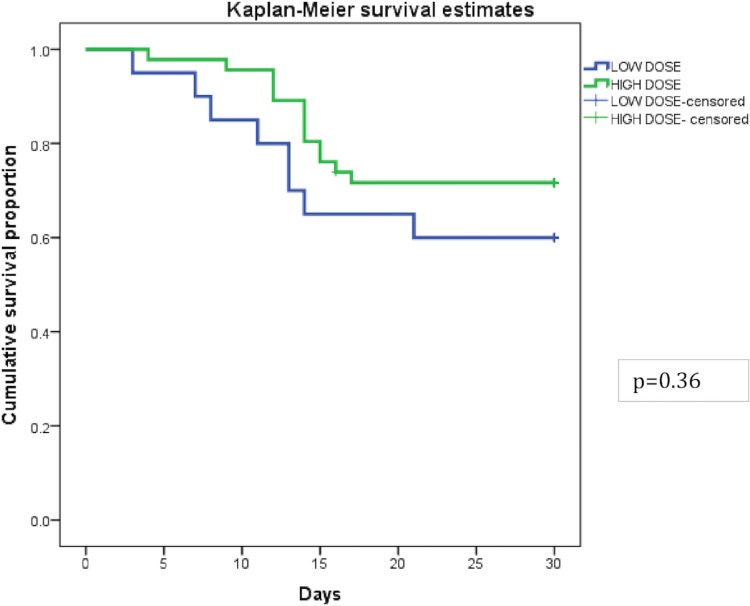
Kaplan Meier survival curves for infectious episodes (IEs) given high dose GTX (≥50 x 109/L) versus low dose GTX (<50 x 109/ L).